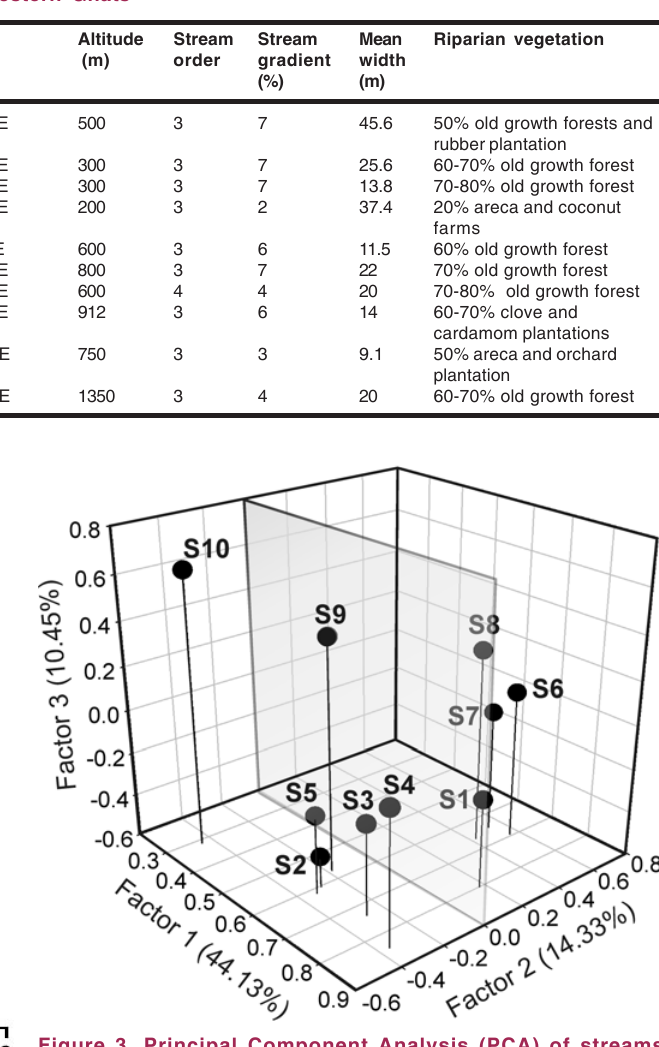
Table 1. Summary of study sites characters in southern Western Ghats